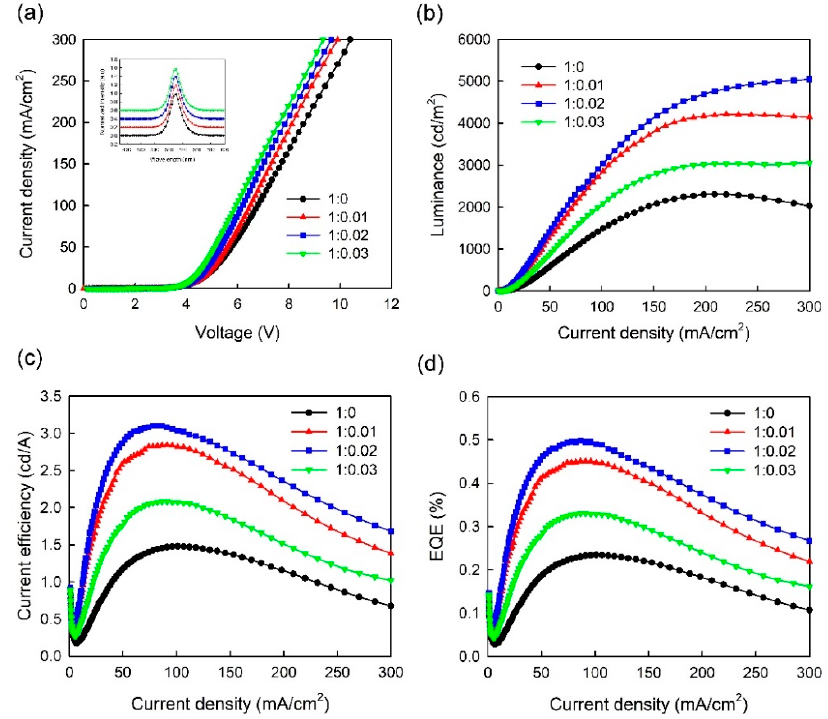
Figure 6. ( a ) J-V, ( b ) L-J, ( c ) CE-J, ( d ) EQE-J curves of PeLEDs with a three-step spin-coated emitter and a PEDOT:PSS/MoO 3 -ammonia (1:0, 1:0.01, 1:0.02, 1:0.03) composite HTL (device T1, T2, T3, T4). The inset is normalized EL spectra of the PeLED devices at 20 mA/cm 2 , which were shifted vertically for clarity. Table 2. Summary of the device parameters of PeLEDs (device T1, T2, T3, T4) with a three-step spin- coated emitter and a PEDOT:PSS/MoO 3 -ammonia (1:0, 1:0.01, 1:0,02, 1:0.03) composite HTL.